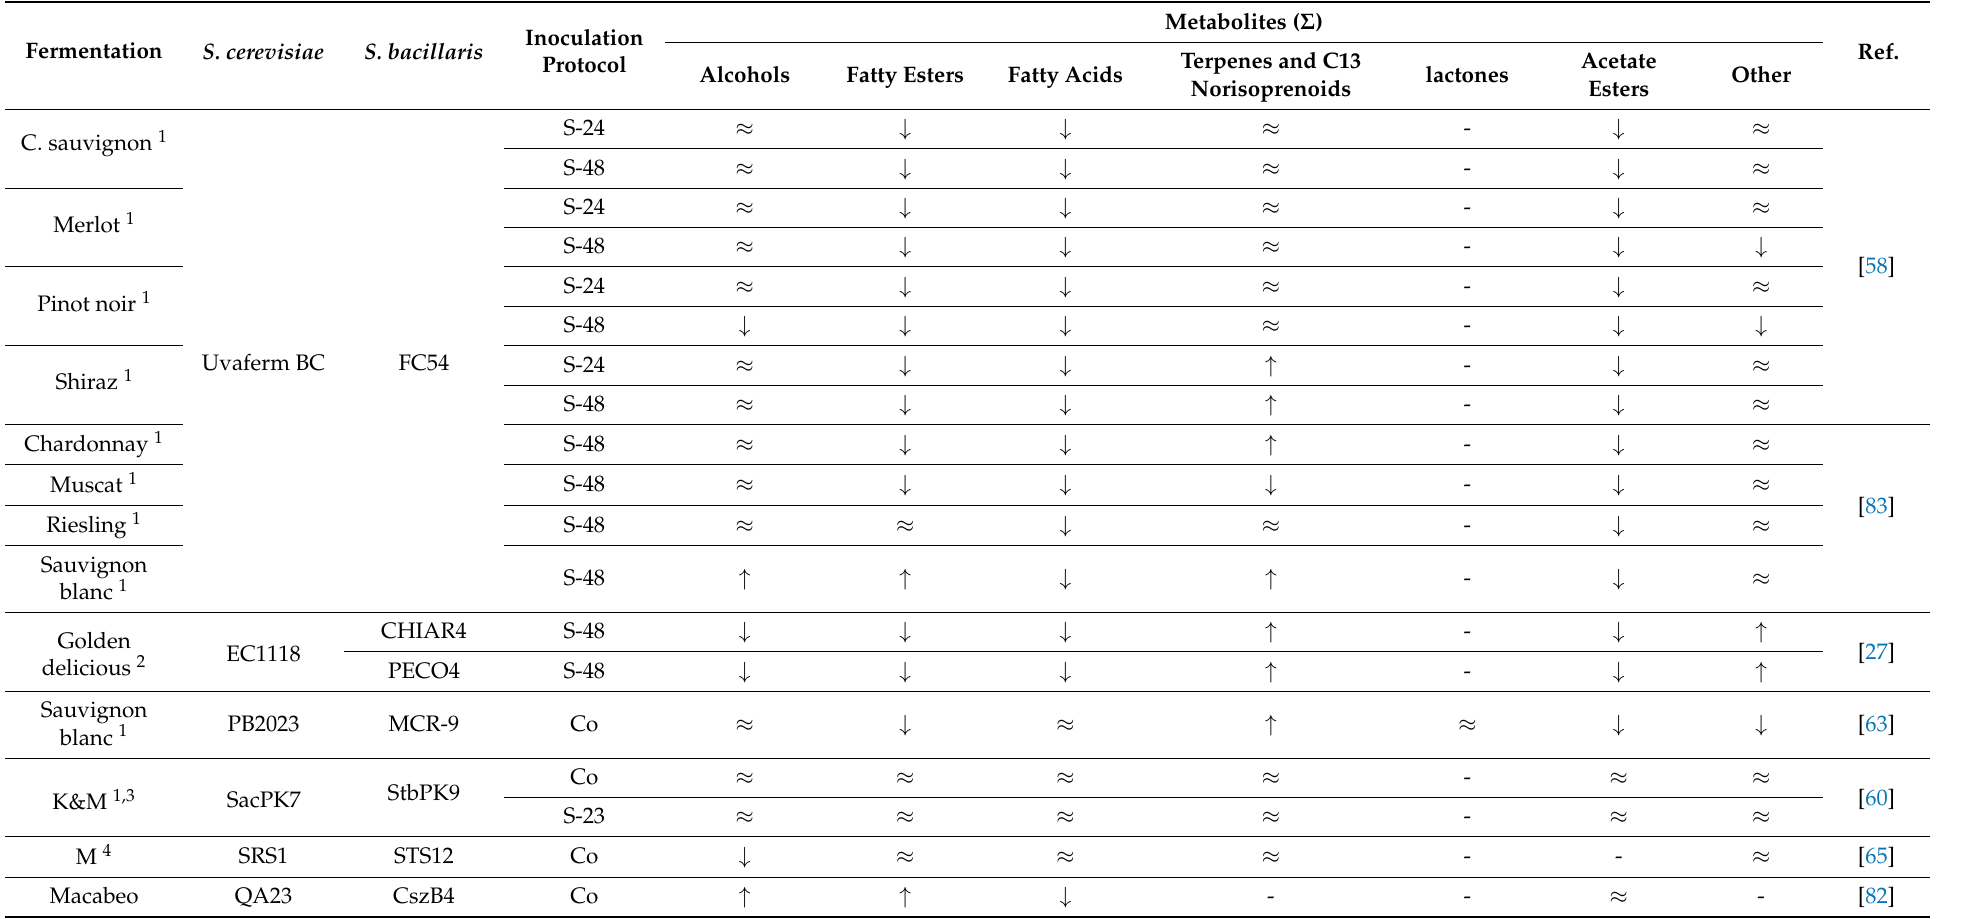
Table 2. Volatile metabolites in S. bacillaris and S. cerevisiae mixed